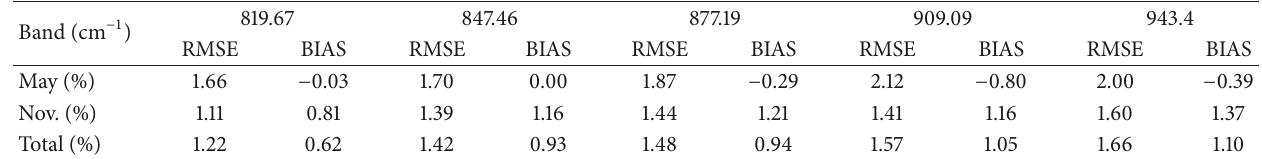
Table 2: Differences between CrIS and AIRS LSE product at 5 AIRS TIR bands.